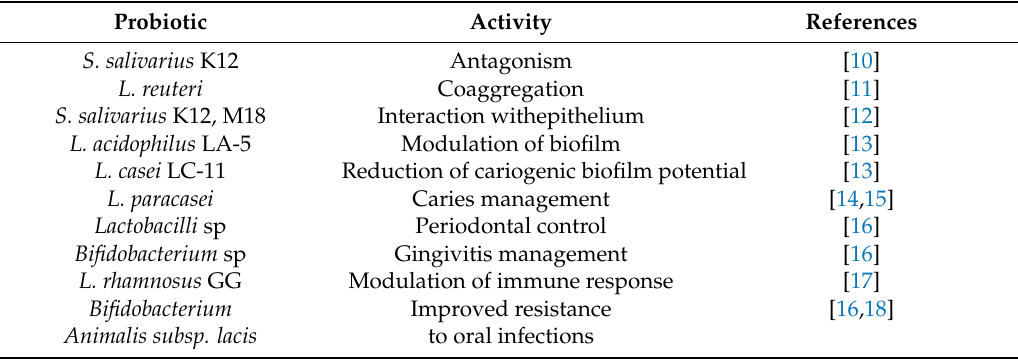
Table 1. Totally or partially proven probiotic activity and mode of action on oral